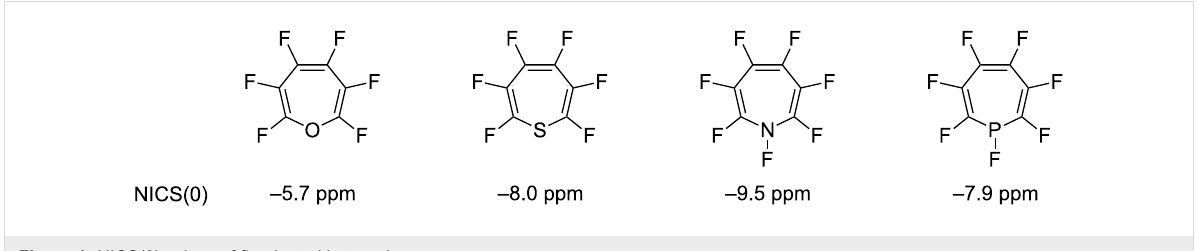
Figure 1: NICS(0) values of fluorinated